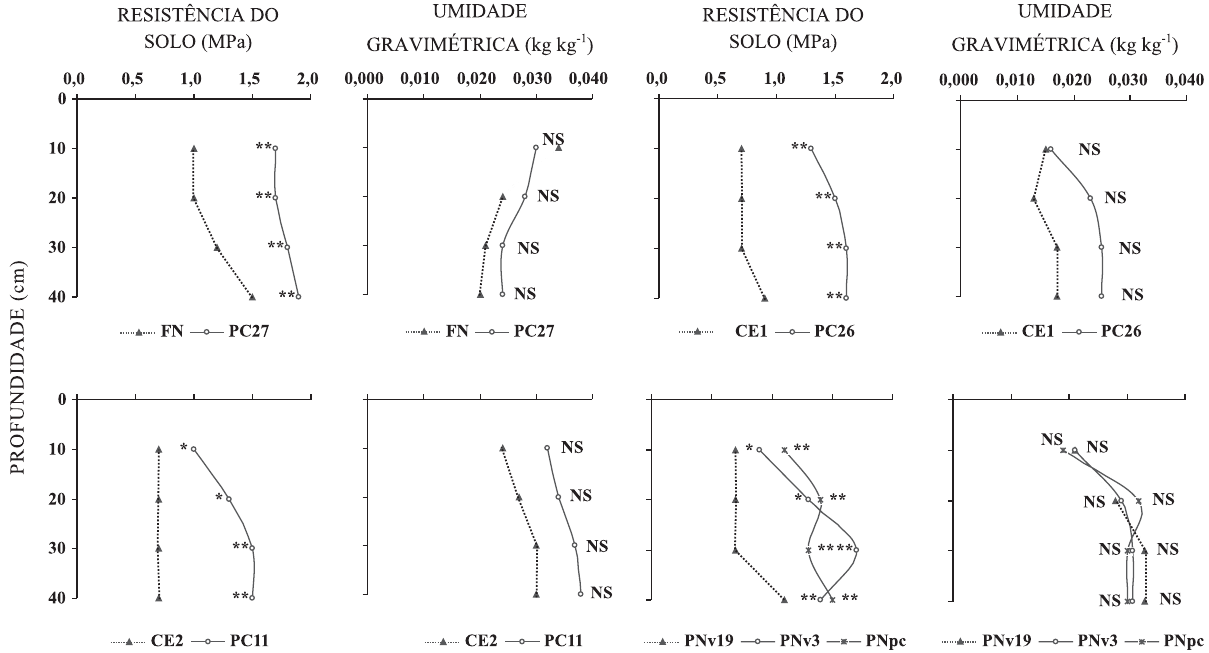
Figura 1. Resistência à penetração e umidade do solo em diferentes ambientes no Pantanal Sul Mato- Grossense (FN: mata semidecídua; CE1 e CE2: Cerradão; PC27, PC26, PC11: respectivamente, pastagem cultivada com 27, 26 e 11 anos de formação; PNpc, PNv3, PNv19: respectivamente, pastagem nativa sob pastejo contínuo e sem pastejo por 3 e 19 anos; * e ** : indicação de significância a 5 e 1 %, nas respectivas profundidades, nos contrastes FN vs PC27, CE1 vs PC26, CE2 vs PC11, PNv3 vs PNpc e PNv19 vs